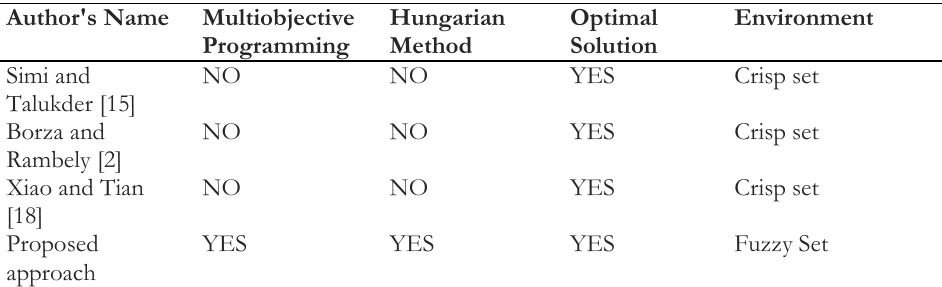
Table 1. Comparison of different researcher's